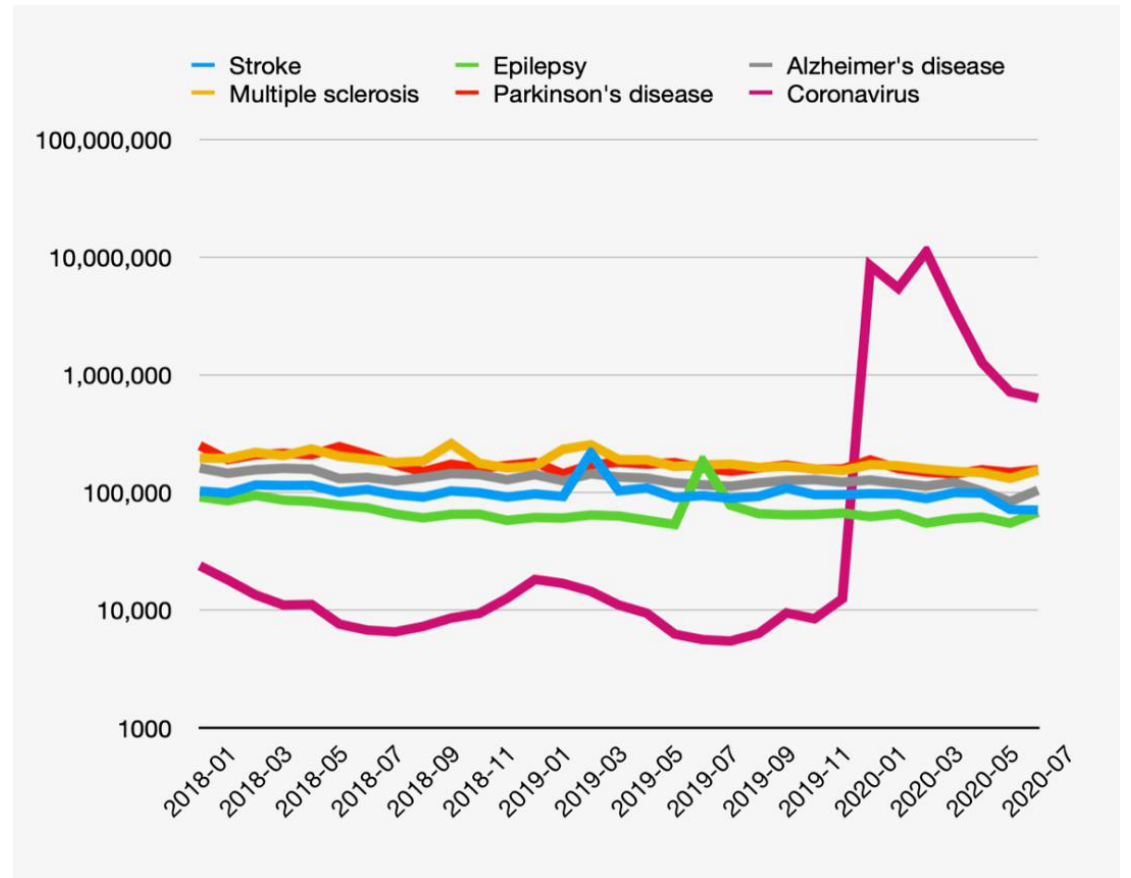
Figure 1. Trends in monthly views of Wikipedia pages for selected neurological conditions and coronavirus from January 2018 to July 2020 presented in a logarithmic